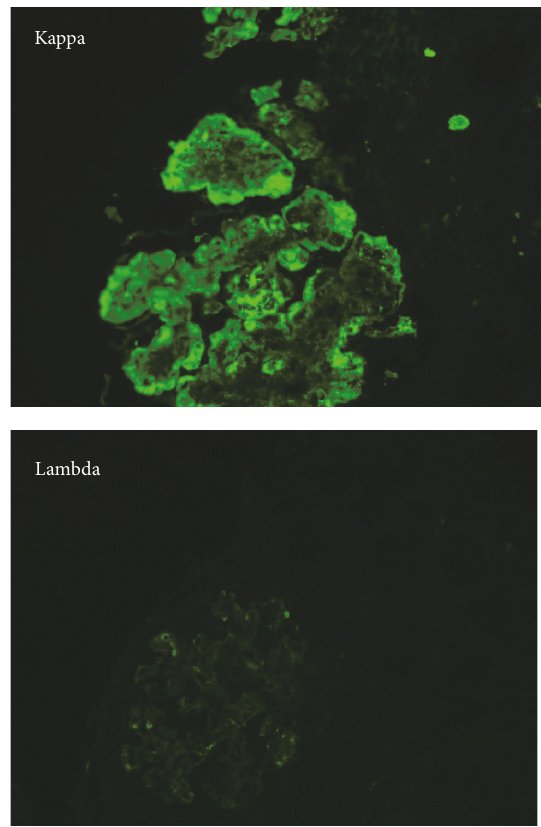
Figure 2: Immunofluorescence microscopy: Kappa light chain deposits within the glomerulus. Lambda light chain is negative.